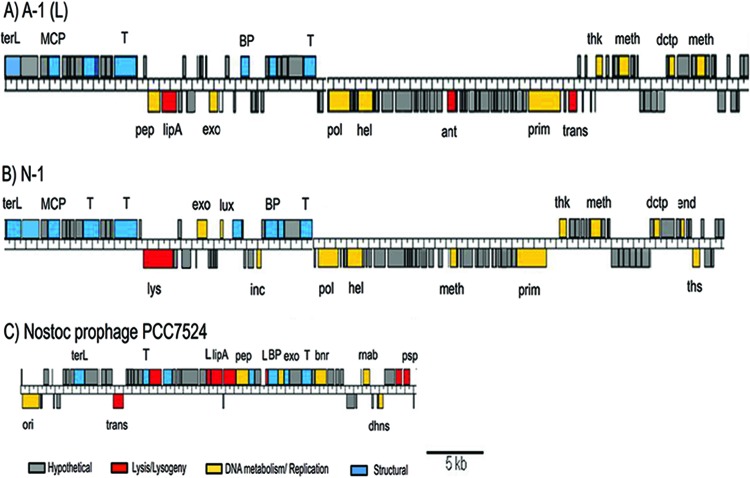
Comparative genomics of the two Nostoc cyanophages and the prophage-like element in the genome of Nostoc sp. strain PCC 7524. The genomes are presented as linear molecules for better comparison. A, cyanophage A-1; B, cyanophage N-1; C, prophage-like element in the genome of Nostoc sp. strain PCC 7524 (accession no. NC019684.1). Gene abbreviations and functions are as follows: ant, antirepressor; BP, baseplate; bnr, bnr/Asp-box repeat protein; dctp, dCTP deaminase; dhns, dihydroxynaphthoate synthase; exo, exonuclease; hel, helicase; incl, viral A inclusion factor; L, lysozyme; lipA, lipoprotein A; luX, LuxR transcription factor, lyz, lysozyme; MCP, major capsid protein; meth, methylase; ori, origin of replication; pep, peptidase; psp, phage shock protein; pol, DNA Pol B; prim, primase; T, tail; terL, terminase large subunit; thk, thymidylate kinase; ths, thymidylate synthase; trans, transposase.